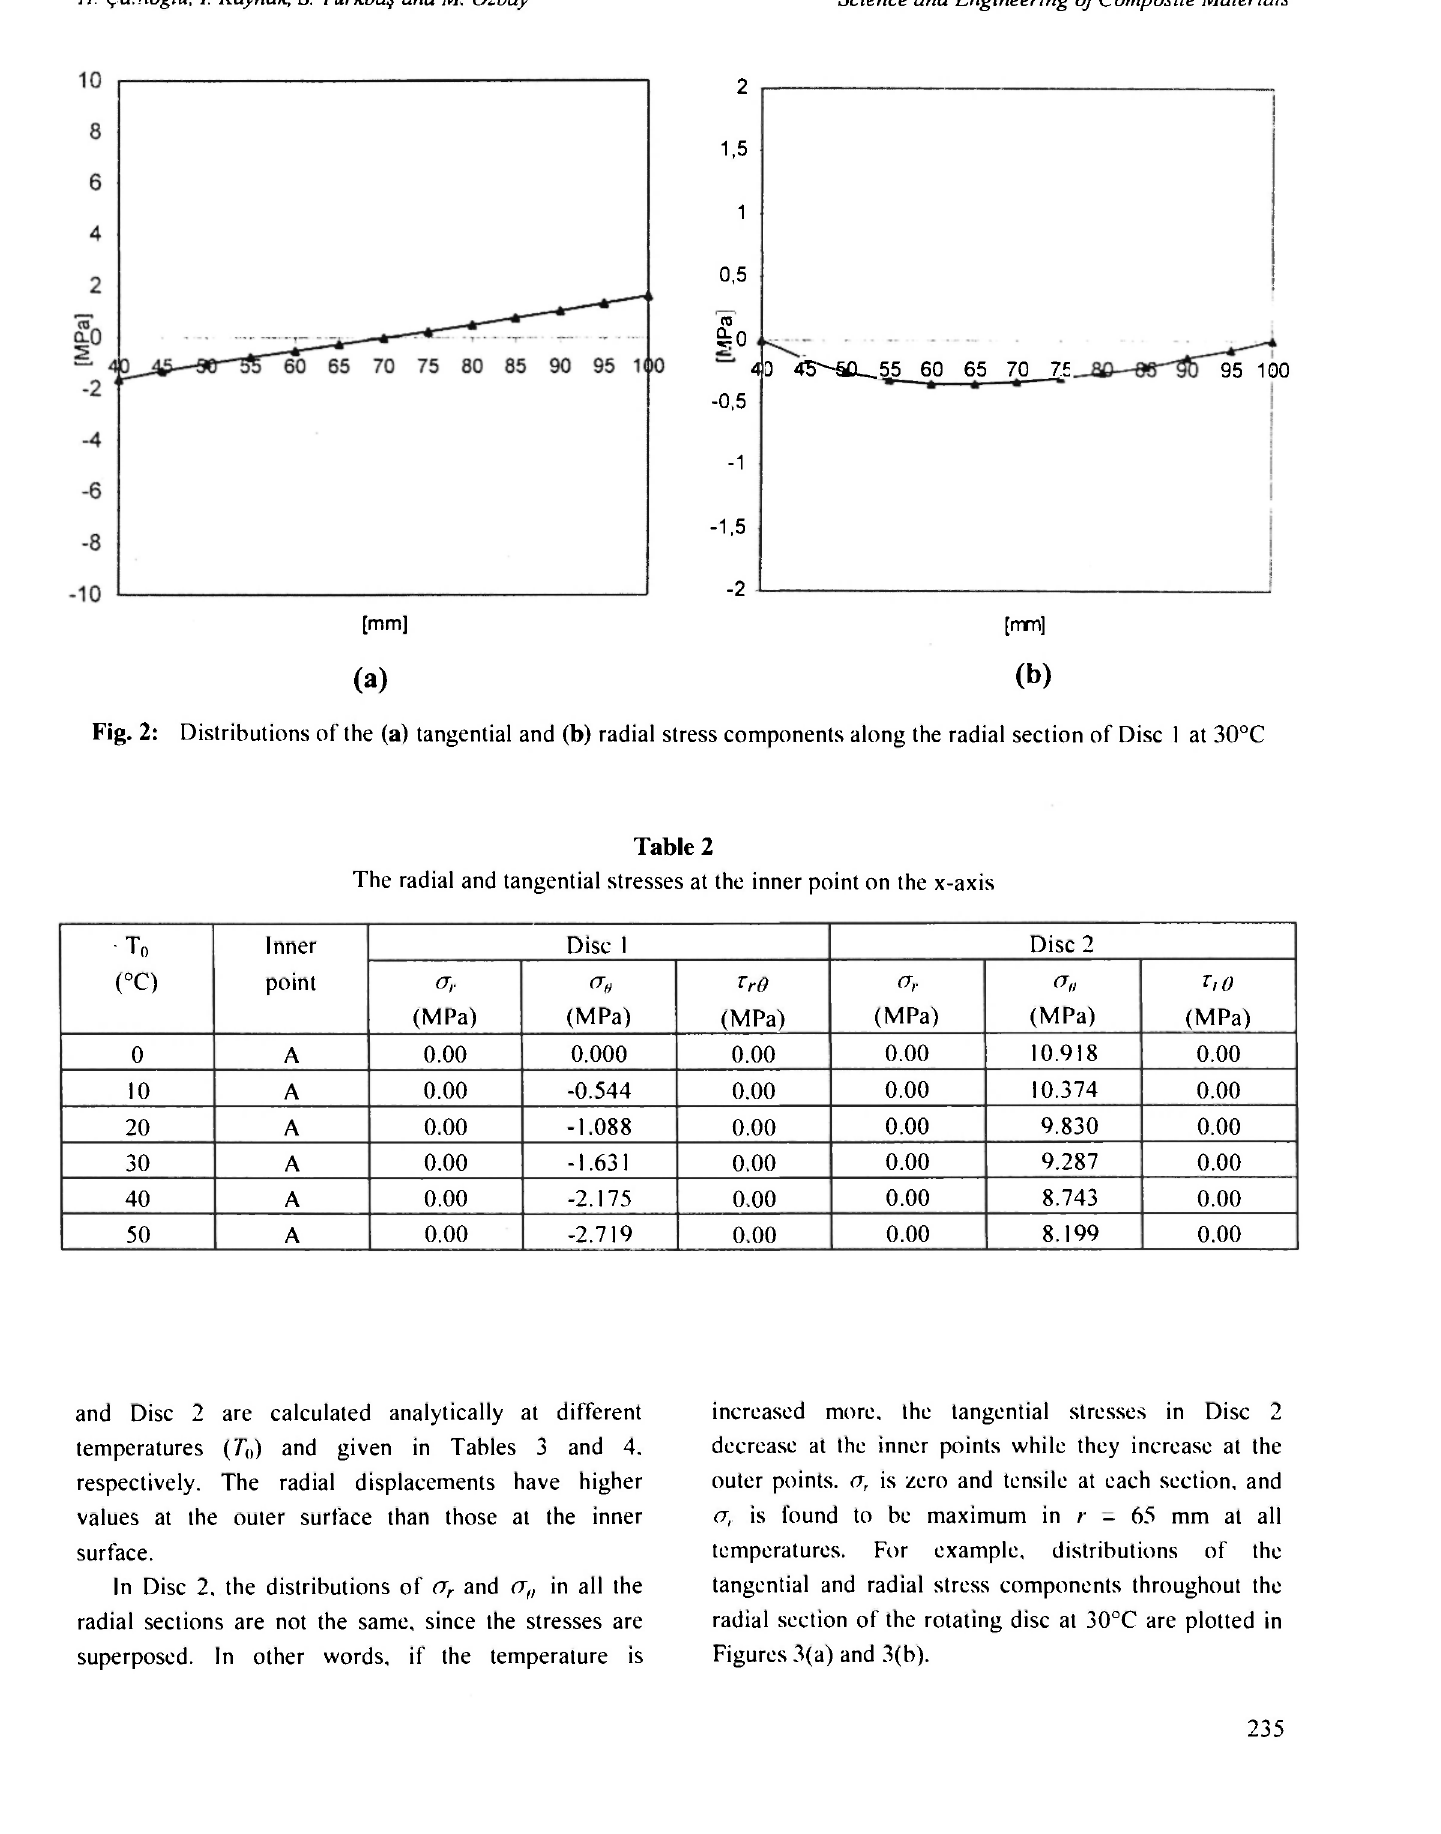
[mm] [mm] (a) (b) Fig. 2: Distributions of the (a) tangential and (b) radial stress components along the radial section of Disc 1 at 30°C